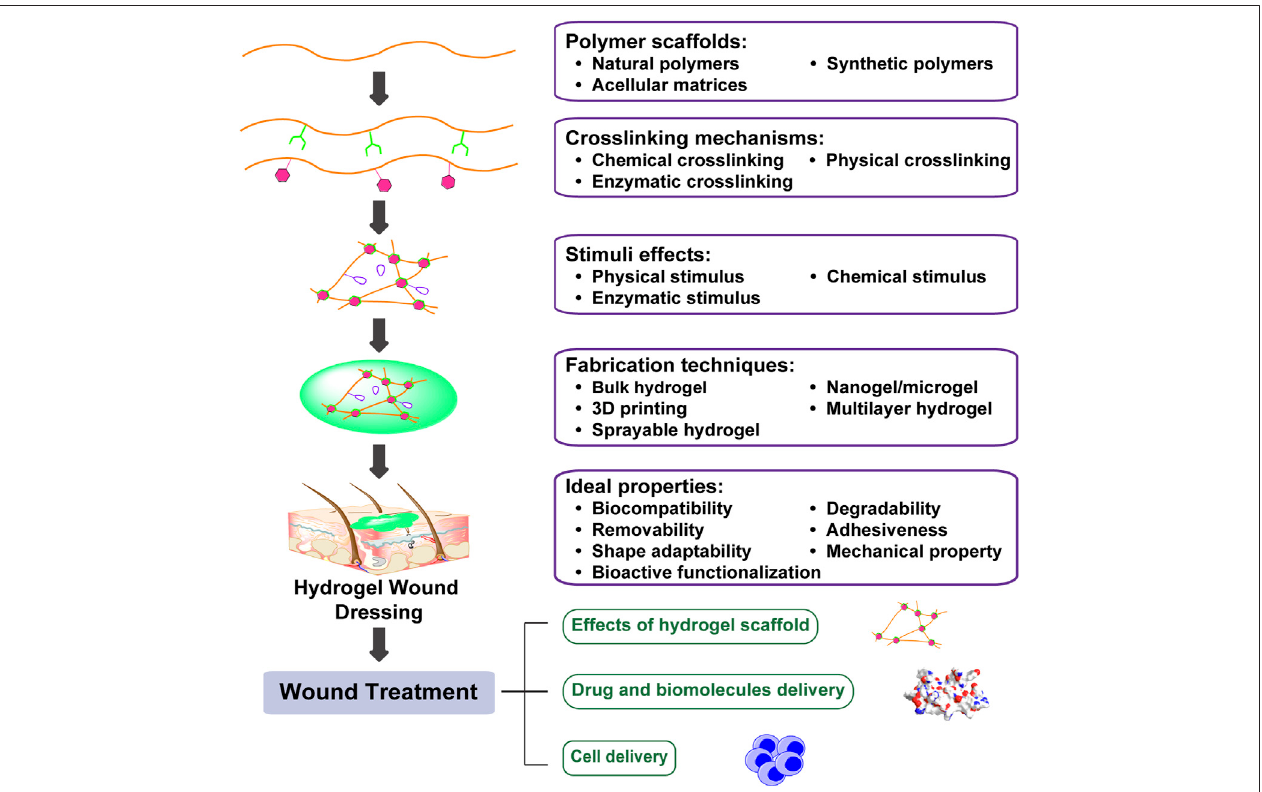
FIGURE 1 | Engineering biomimetic hydrogels to promote wound healing. Hydrogels are hydrophilic networks primarily made of polymer scaffolds by various crosslinking mechanisms. Furthermore, incorporation of stimuli effects generates hydrogels with tunable dynamics. Tuning polymer scaffolds, crosslinking mechanism, stimuli effects, as well as fabrication techniques can enhance hydrogel bioactivities and promote wound healing through drug and biomolecules delivery, as well as cell delivery.